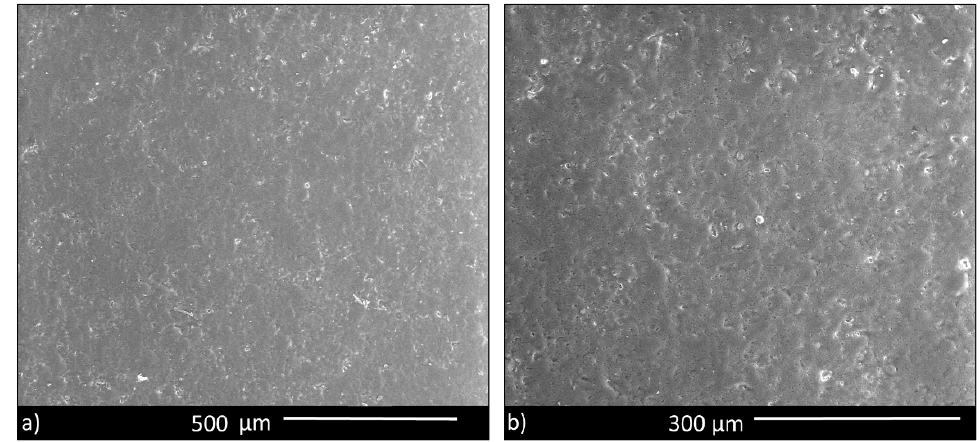
Figure 3. ( a ) BGMSN sintered disk, showing a good densification; ( b ) higher magnification image.